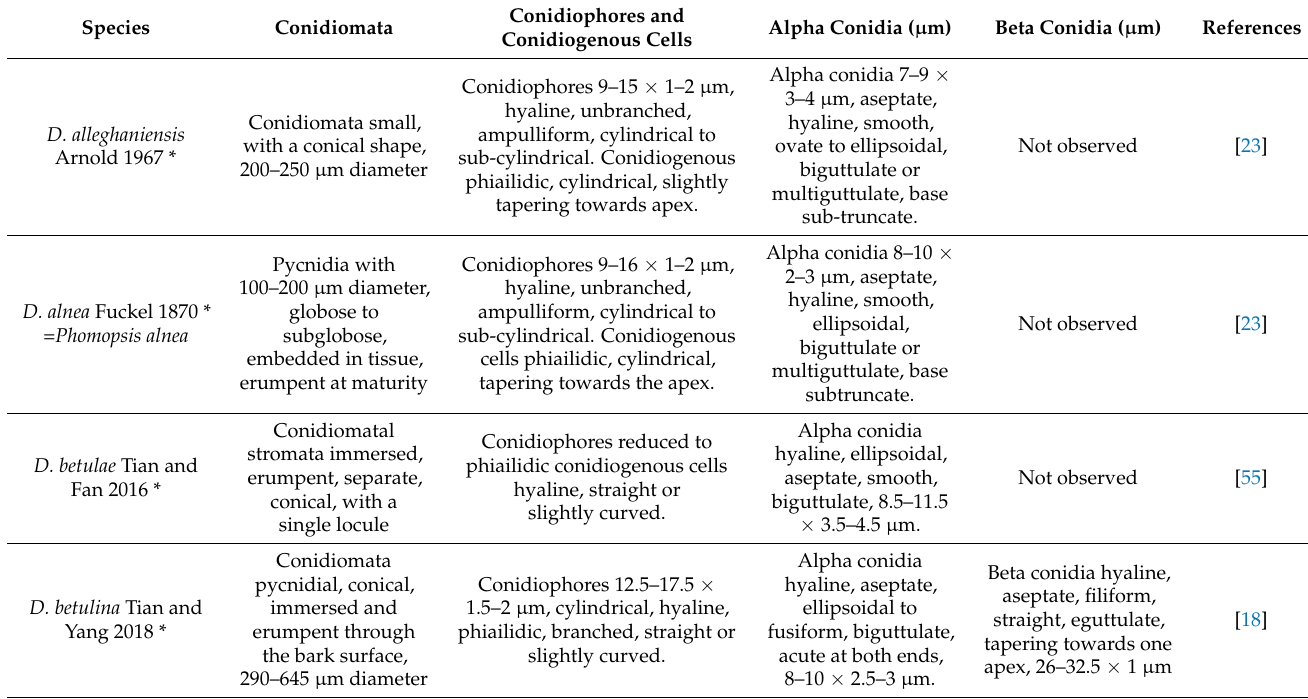
Table 4. Synopsis of morphological characteristics of Diaporthe eres synonymous discussed in this study. (Note: the taxonomic description of D. neilliae was not included as its asexual morph is